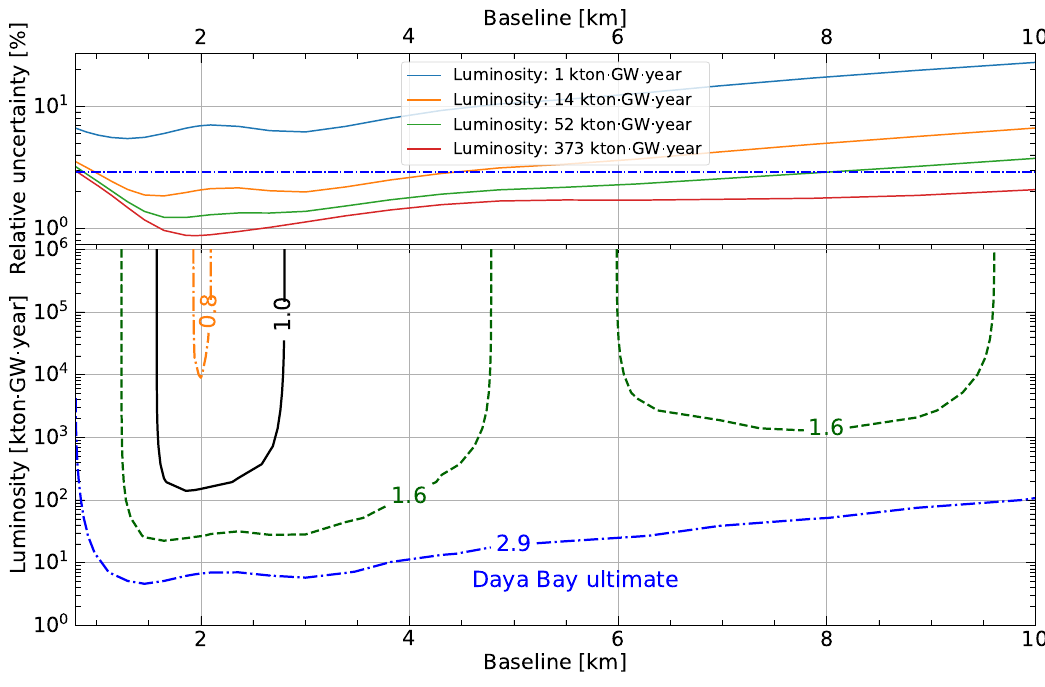
Figure 4 . The 1 σ contour of the precision measurement sensitivity on sin 2 θ 13 for different base- lines and integrated luminosities. The top pad shows the sensitivity as a function of baselines for luminosities of 1, 14, 52, and 373 kton · GW · year . The luminosities are arbitrarily selected to present the evolution of the baseline’s preference. The optimal baseline shifts from ∼ 1 . 3 km at low statistics to ∼ 2 . 0 km at high statistics. The ultimate precision of the Daya Bay experiment is also shown with a horizontal blue dash-dotted line. The bottom pad shows the required luminosity to reach 0.8% (orange dash-dotted line), 1.0% (black line), 1.6% (green dash line), and 2.9% (dash- dotted blue line) precision at different baselines. The spectral shape uncertainty is constrained by the TAO